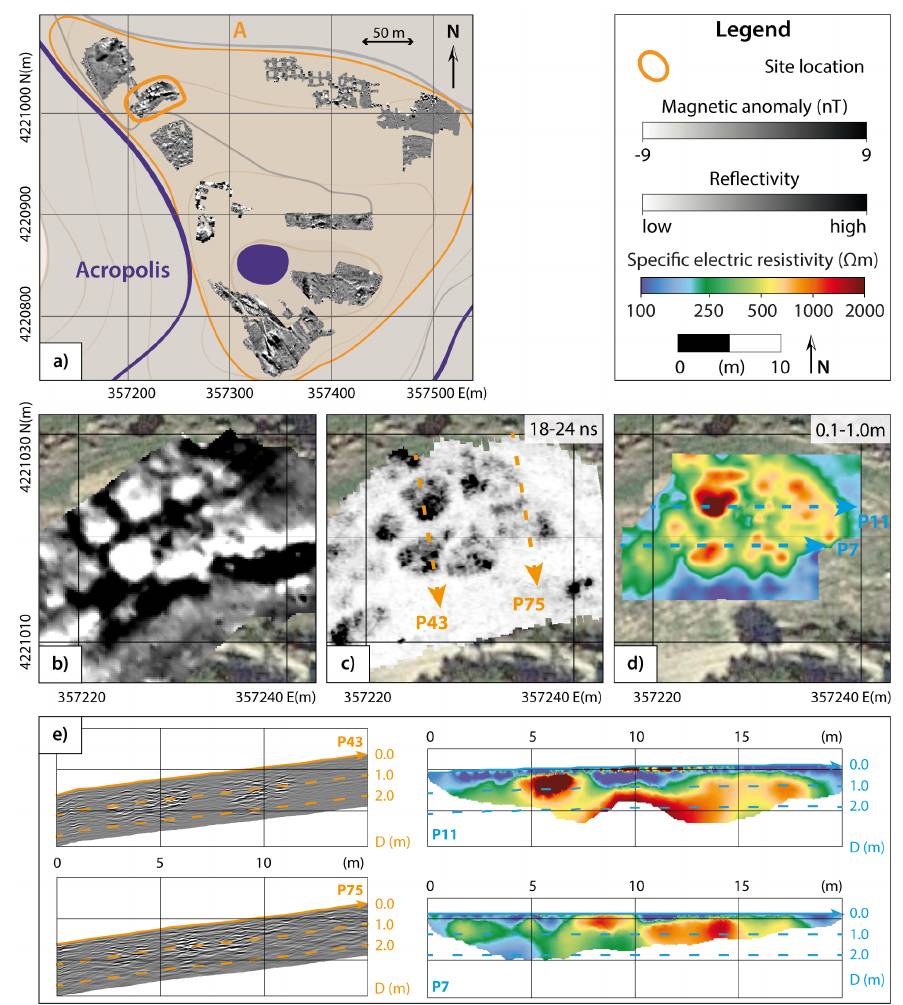
Figure 5. Case 2: Third terrace underneath and northwest of Aigeira’s acropolis. ( a ) Sketch of the first survey area in Aigeira (cf. area A in Figure 1b) with the magnetic map. The site location is marked (cf. Figure 3). ( b ) Magnetic map. ( c ) Ground-penetrating radar (GPR) timeslice. ( d ) Electrical resistivity tomography (ERT) depthslice. ( e ) Radargrams of P43 and P75 as well as the ERT depth sections of P7 and P11, which include only valid measurements with a standard deviation σ < 5 Ω m. Their location is shown in panel ( c ) or ( d ), respectively. (Source of satellite images ( b – d ): Google